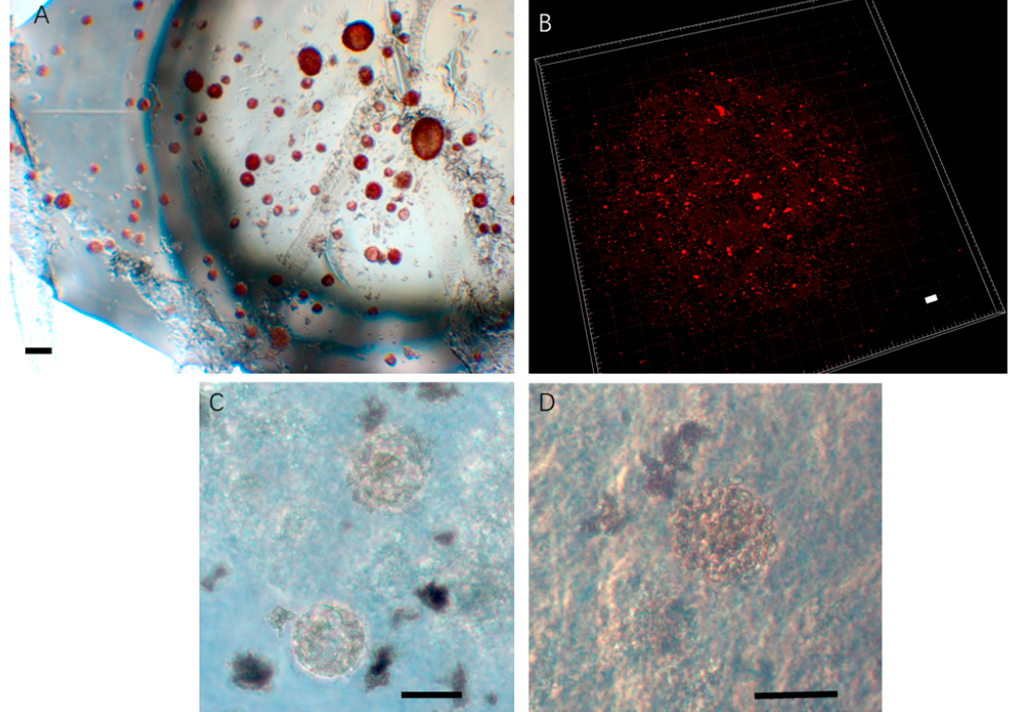
Figure 4. Follicles obtained from two-time cryopreserved ovarian tissues for construction of artificial ovaries. ( A ) Isolated live follicles stained by neutral red. ( B ) Artificial ovary stained by RedDot using Imaris 9.0. ( C ) Live primordial follicles from cryopreserved ovarian tissue in fibrin–thrombin complex. ( D ) Live primary follicles from cryopreserved tissue in fi brin–thrombin complex. Bar = 50 µm.